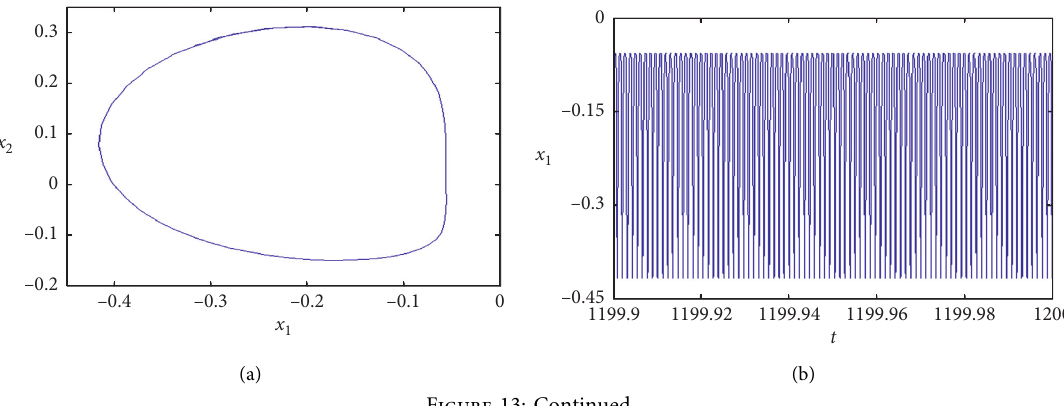
� 31 . 5. (a) Phase portrait on plane ( x 0 ) , (e) three-dimensional phase portrait in space ( x 3